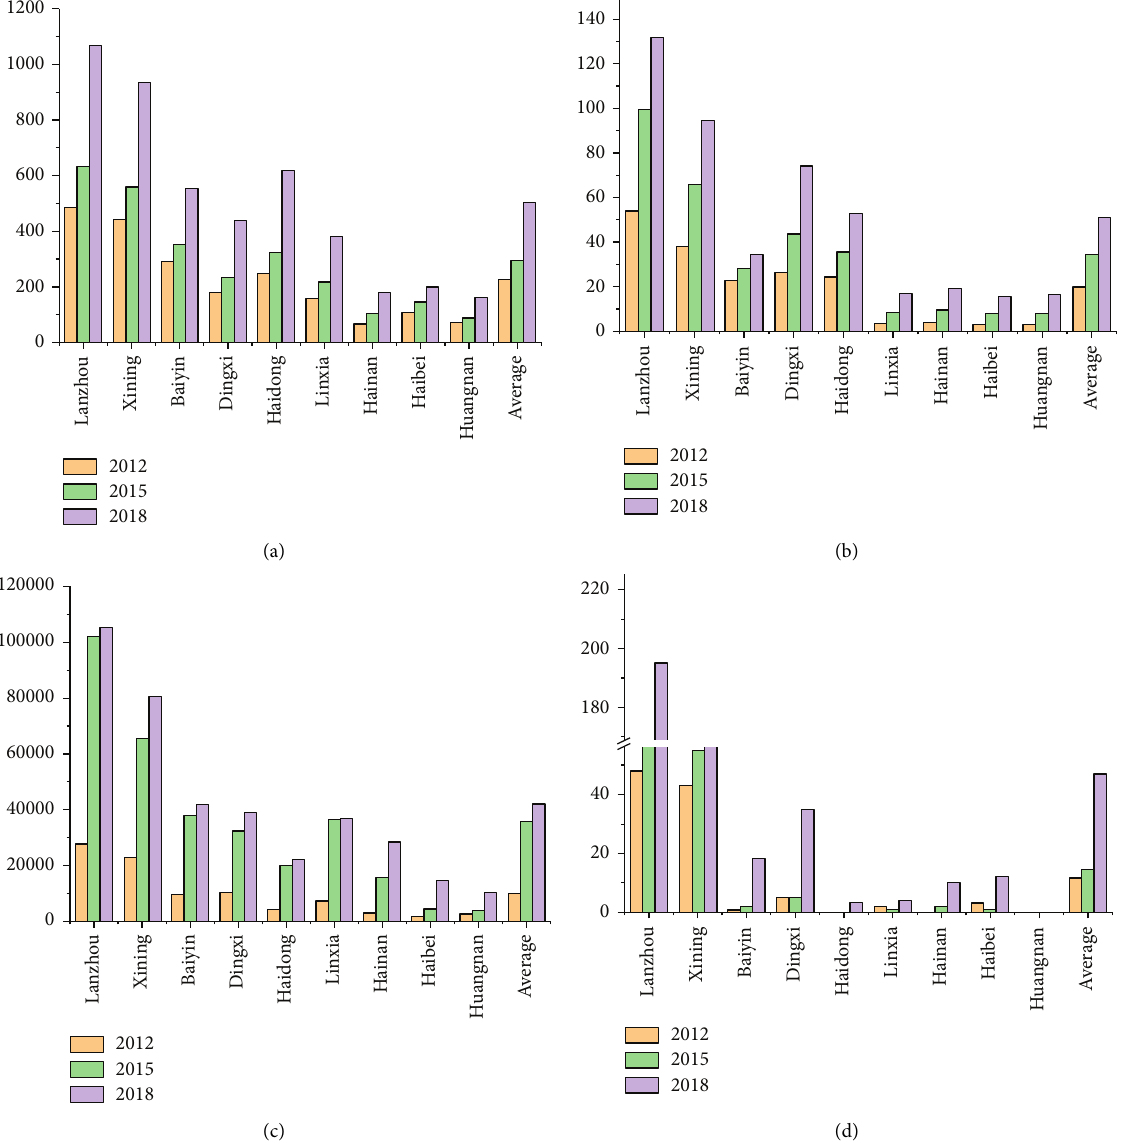
Figure 3: The four dimensions of urban connection indexes in Lanzhou-Xining urban agglomeration. (a) Industrial connection, (b) transportation connection, (c) information connection, and (d) innovative